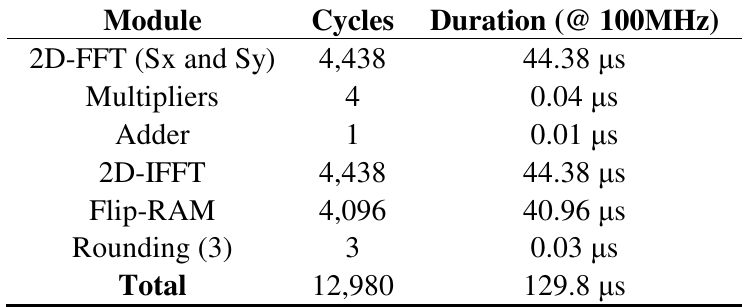
Table 2. Execution time (latency) for the different stages of the phase recoverer.